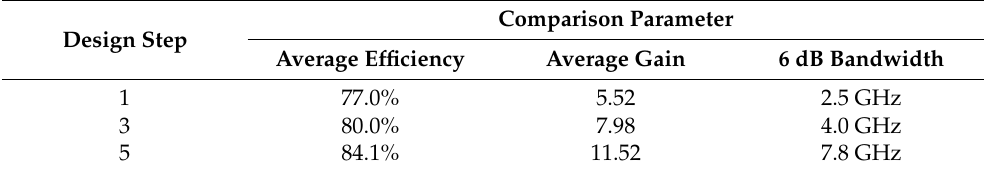
Table 2. A comparison between different configurations of the design